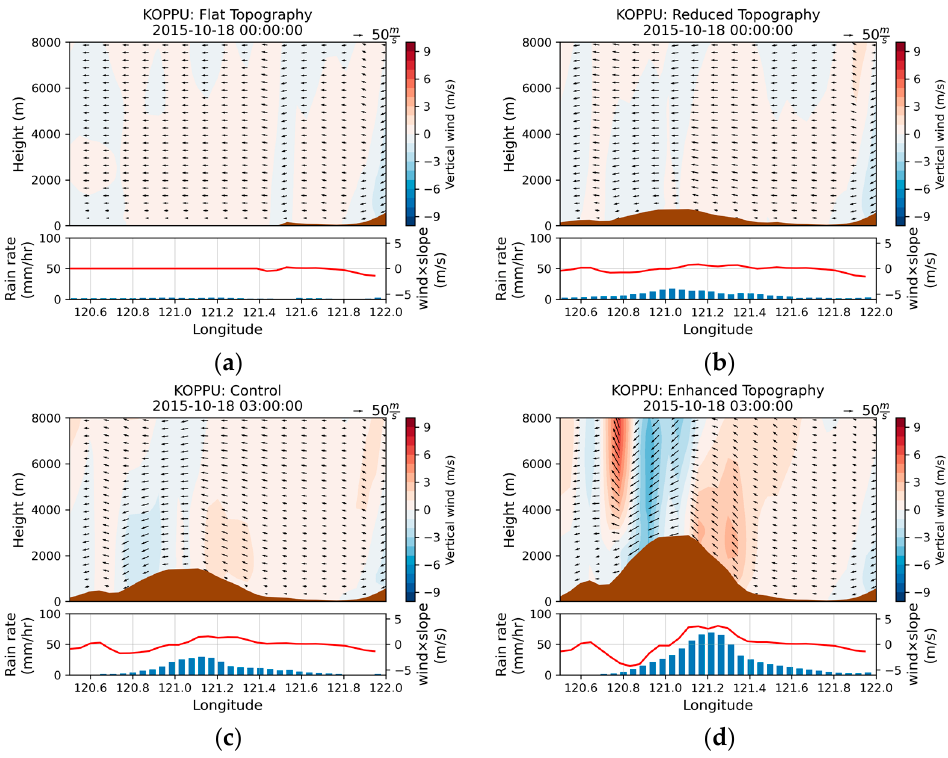
Figure 13. Zonal–vertical cross-section (averaged across the latitude range of the “Central” region shown in Figure 11) of vertical wind (red–blue shading) and mountain height (filled brown curve) during TC Koppu landfall (upper part of each panel) and the average precipitation along the cross- section (lower part of each panel) for ( a ) Flat, ( b ) Reduced, ( c ) Control, and ( d ) Enhanced. In the lower panels, red lines represent the product of the wind speed and slope, and blue bars show the average precipitation.